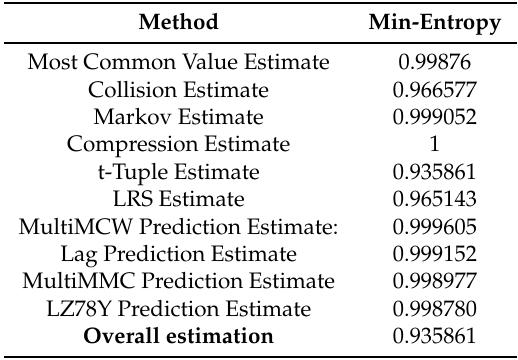
Table 1. Min-entropy results (NIST SP 800-90B Suite).